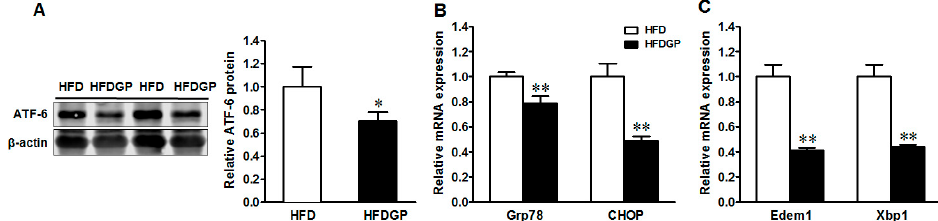
Figure 5. Endoplasmic reticulum (ER)-stress signaling in the colon of HFD or HFDGP fed DSS-colitis mice. ( A ) ATF-6 protein content; ( B ) mRNA expression of Grp78 and CHOP; ( C ) mRNA expression of Edem1 and Xbp1. Means ± SEM, n = 7, * p ≤ 0.05, ** p ≤ 0.01.